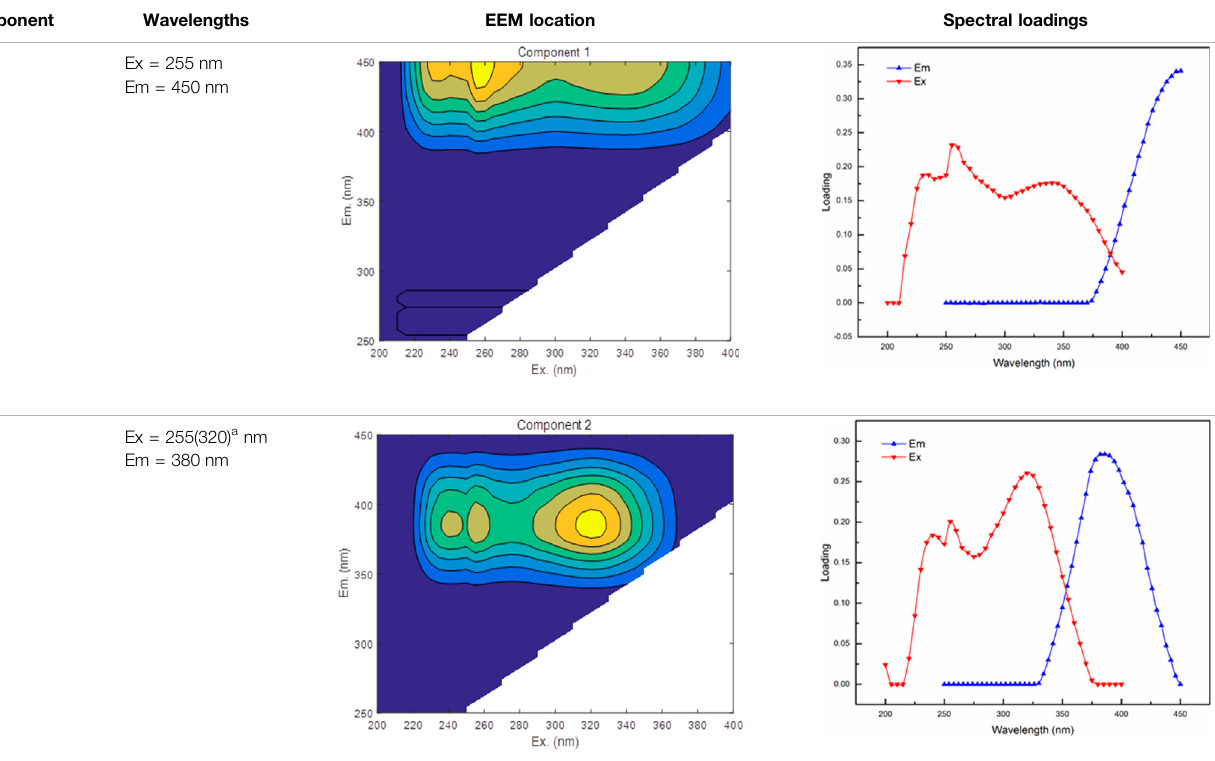
Different letters represent the difference among treatments.